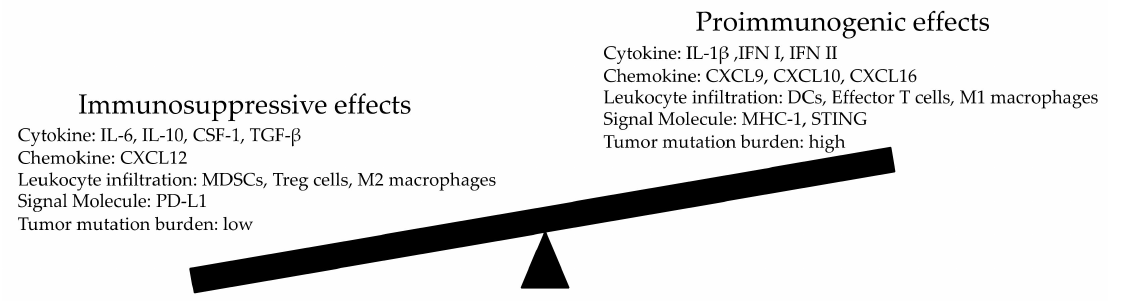
Figure2. Theopposinge ff ectsofradiotherapyonthetumormicroenvironment. Animmunosuppressive microenvironment usually exists in the tumor. Ideally, drug combinations should shift the balance toward the pro-immunogenic and away from the immunosuppressive e ff ect of radiotherapy to favor its pro-immunogenic e ff ects and or abrogate the immune-suppressive ones. RT; radiotherapy, IFN; interferon, IL; interleukin, TGF; transforming growth factor, CSF; colony-stimulating factor, CXCL; CXC-motif chemokine ligand, DCs; dendritic cells, MDSCs; myeloid-derived suppressor cells, Treg; regulatory T lymphocytes, MHC; major histocompatibility complex, STING; stimulator of interferon genes, PD-L1; programmed cell death-ligand